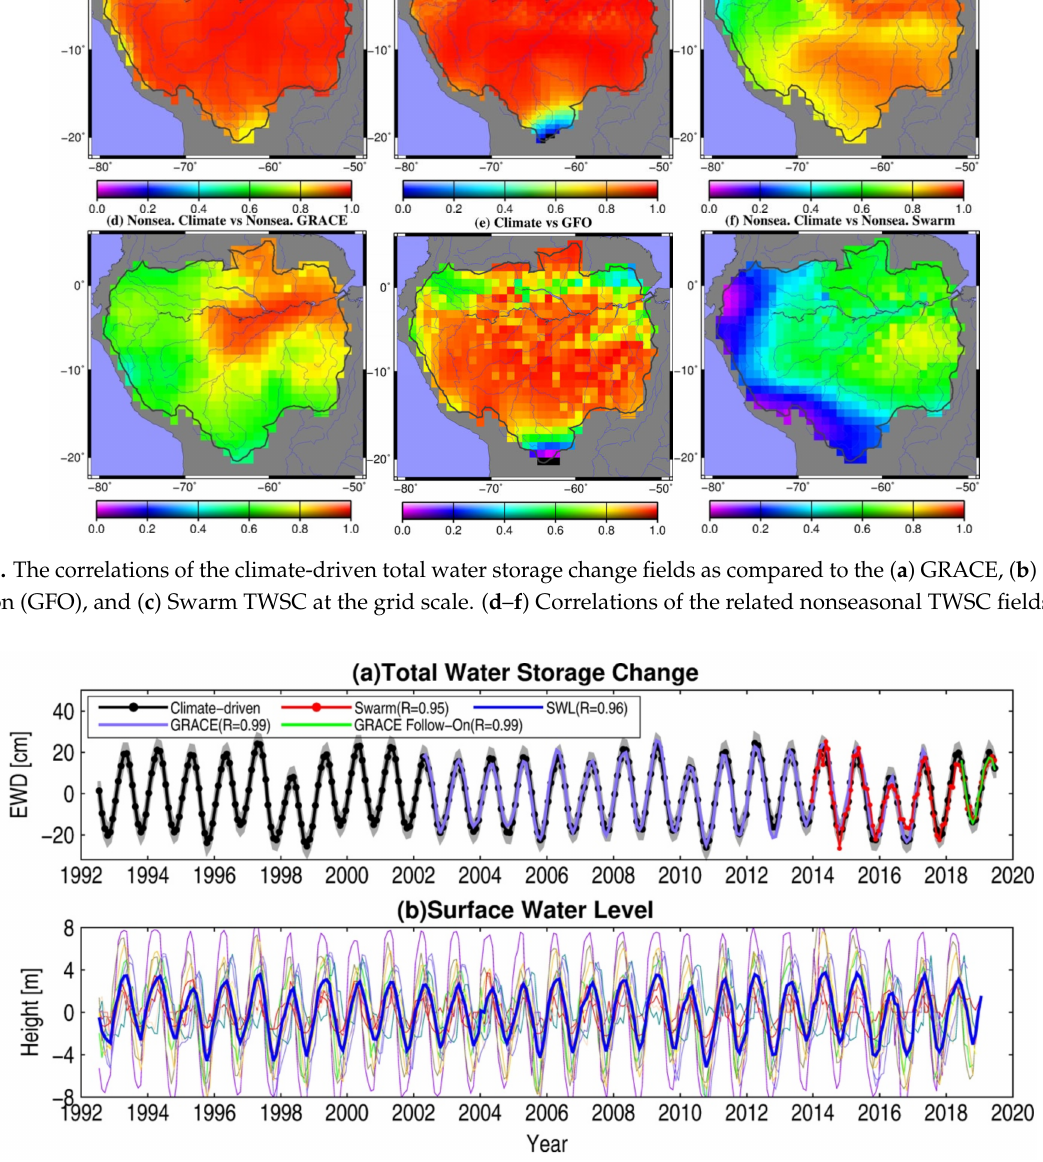
Figure 4. ( a ) The climate-driven TWSC time series in the Amazon basin relative to the TWSC from GRACE, GRACE follow-on, and Swarm. ( b ) The in situ water levels from the 12 in situ gauge stations and the surface water level (blue line) over the Amazon basin. The correlations (R) between the climate-driven TWSC and the other time series are also drawn in the top left of Figure 4a. Note that the surface water level was obtained by averaging all in situ water levels shown in Figure 4b, and the linear trends and mean values of all the time series, for a fair comparison, were removed. The 95% confidence interval for the climate-driven TWSC is drawn in Figure 4a. SWL, surface water level; EWD, equivalent water